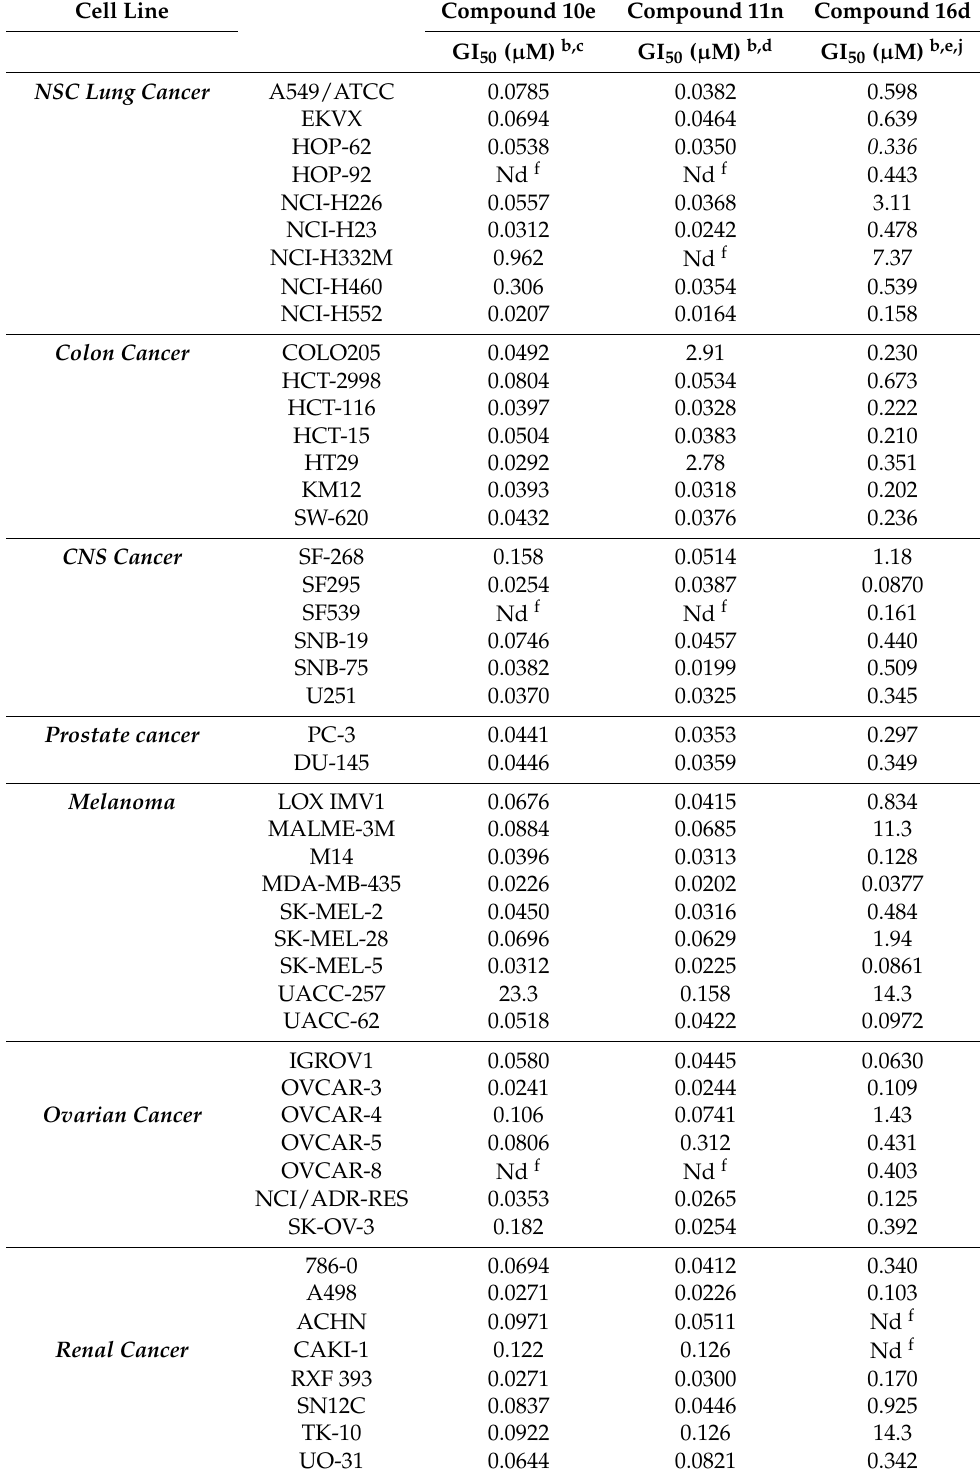
Table 6. Antitumour Evaluation of compounds 10e , 11n and 16d in NCI-60 cell line screen a